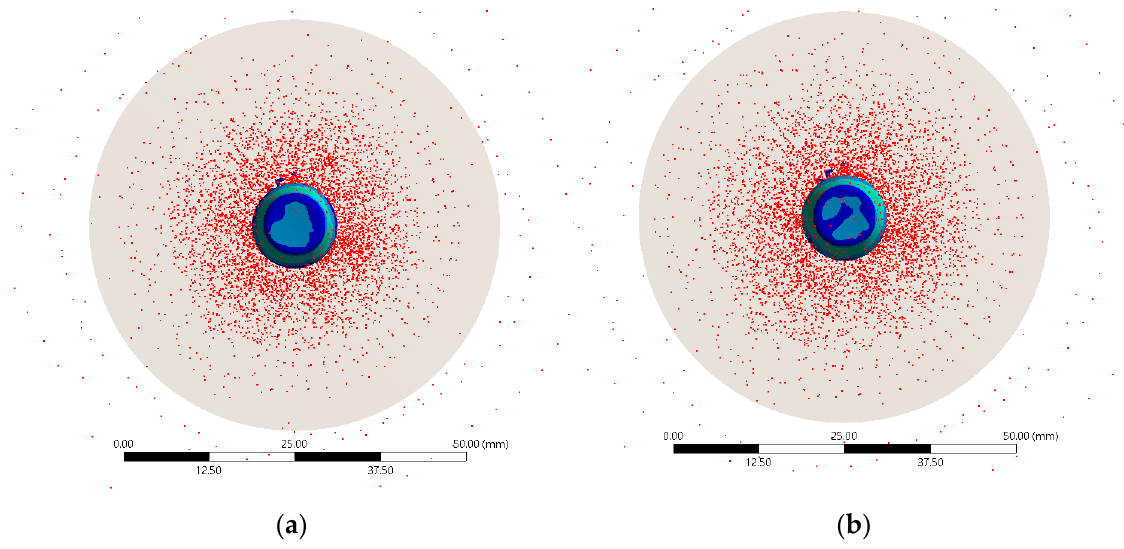
Figure 9. Fragmentation pattern of the projectile ( a ) AMMO 1; ( b ) AMMO 2. mentation results are mapped as Figure 10. Based on this mapping, AMMO 1 in Figure 11a is presented such that the projectile scattering distance which is shown by the ANSYS software is from 0.000 to 0.070 m. Then, the outermost fragment is marked and a straight line is drawn to the center of the impact point which shows 0.0034 m in length. Because the used scale in ANSYS simulation is 1:300, the real distance of the maximum scattering radius for the AMMO 1 is 1.01 m. On the other hand, the scattering region of AMMO 2 shows the measuring length from 0.000 to 0.200 m and the outermost fragment at 0.089 m. These simulation results were then converted to actual scale and the obtained outermost distance of the AMMO 2 was 2.658 m.